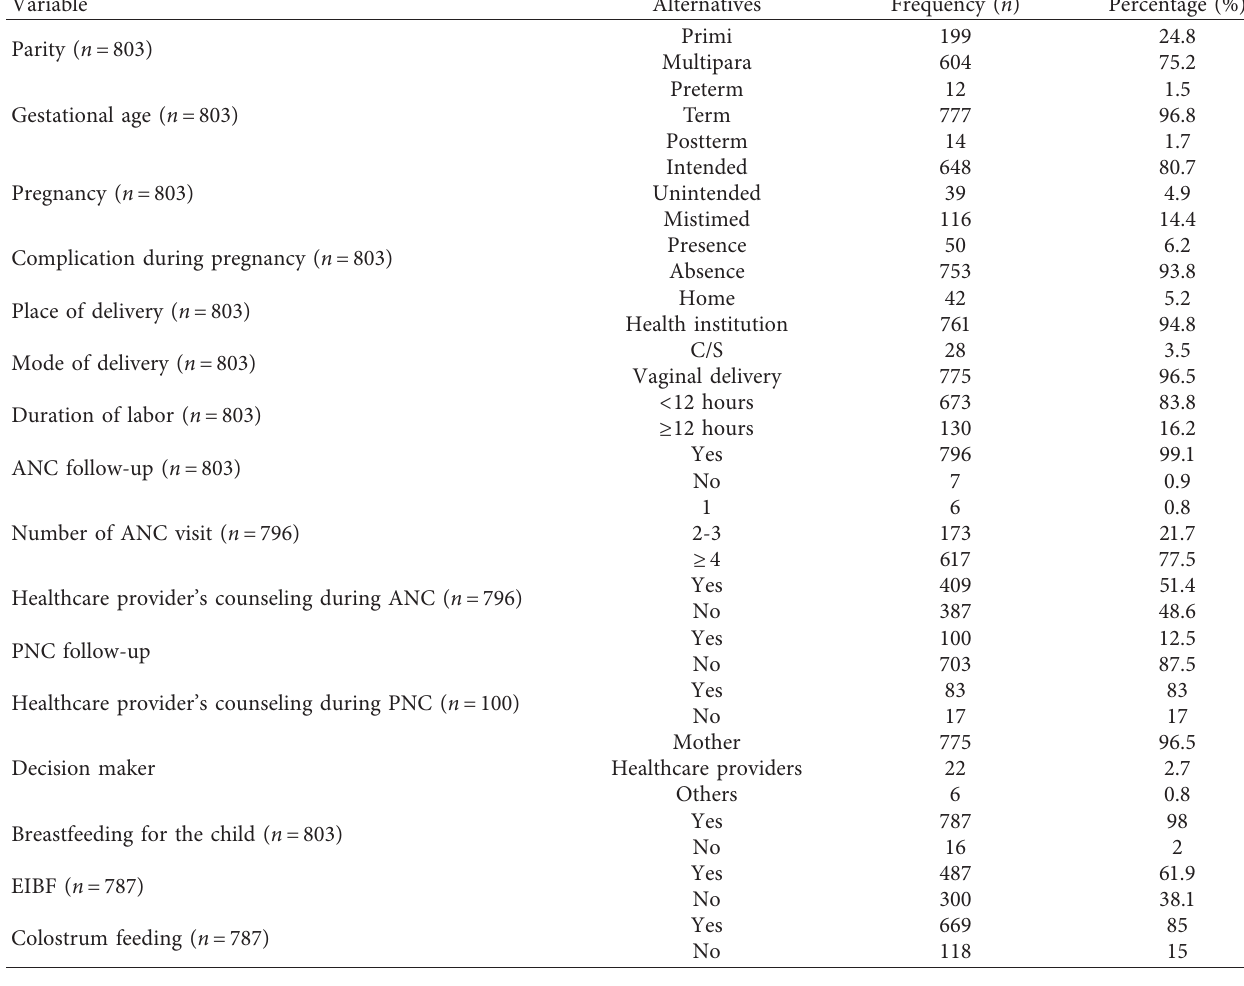
Table 2: Feeding practices and health service utilization among mothers of children aged less than 12 months children in Eastern zone, Tigray, Northern Ethiopia, 2018 ( n � 803).